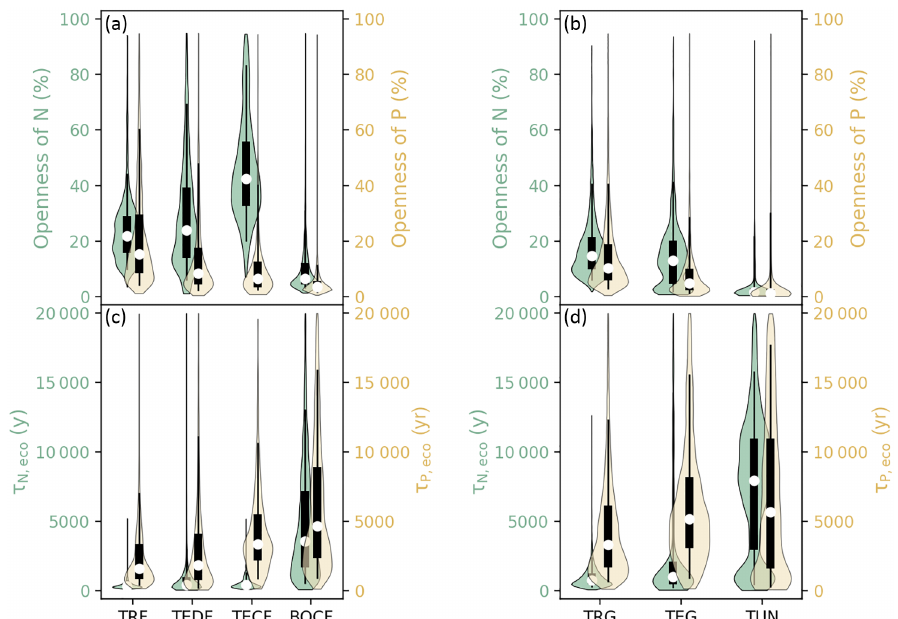
Figure 6. Violin plots of the openness of N and P cycling (the percentage of total plant uptake of N and P attributed to new nutrient inputs) for (a) forest and (b) grassland biomes. Residence times of N ( τ N , eco ) and P ( τ P , eco ) in (c) forest ecosystems and (d) grassland biomes. Open circles are medians of all grid cells within each biome, with balloons representing the probability density distribution of each value. Black whiskers indicate the interquartile (thick) and 95% confidence intervals (thin). The biomes are tropical rainforests (TRF), temperate deciduous forests (TEDF), temperate coniferous forests (TECF), boreal coniferous forests (BOCF), tropical/C 4 grasslands (TRG), temperate/C 3 grasslands (TEG), and tundra (TUN).